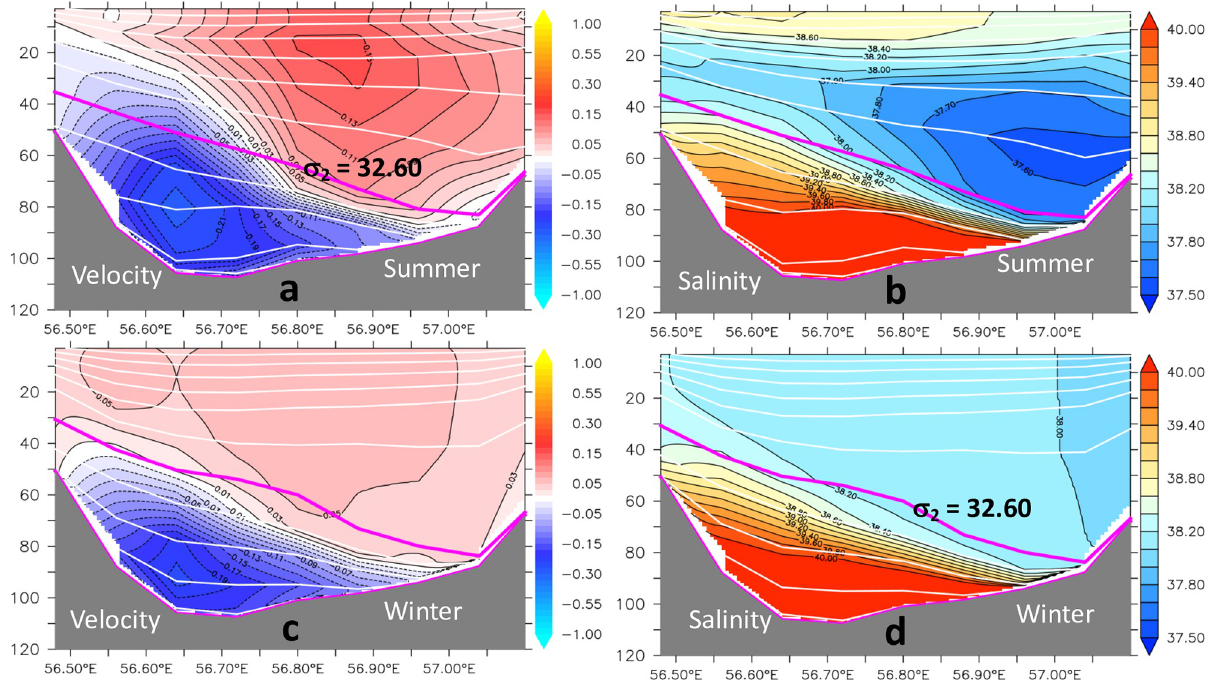
Fig 8. Summer and winter distributions of the meridional velocity and salinity at the Hormuz section (26˚N).